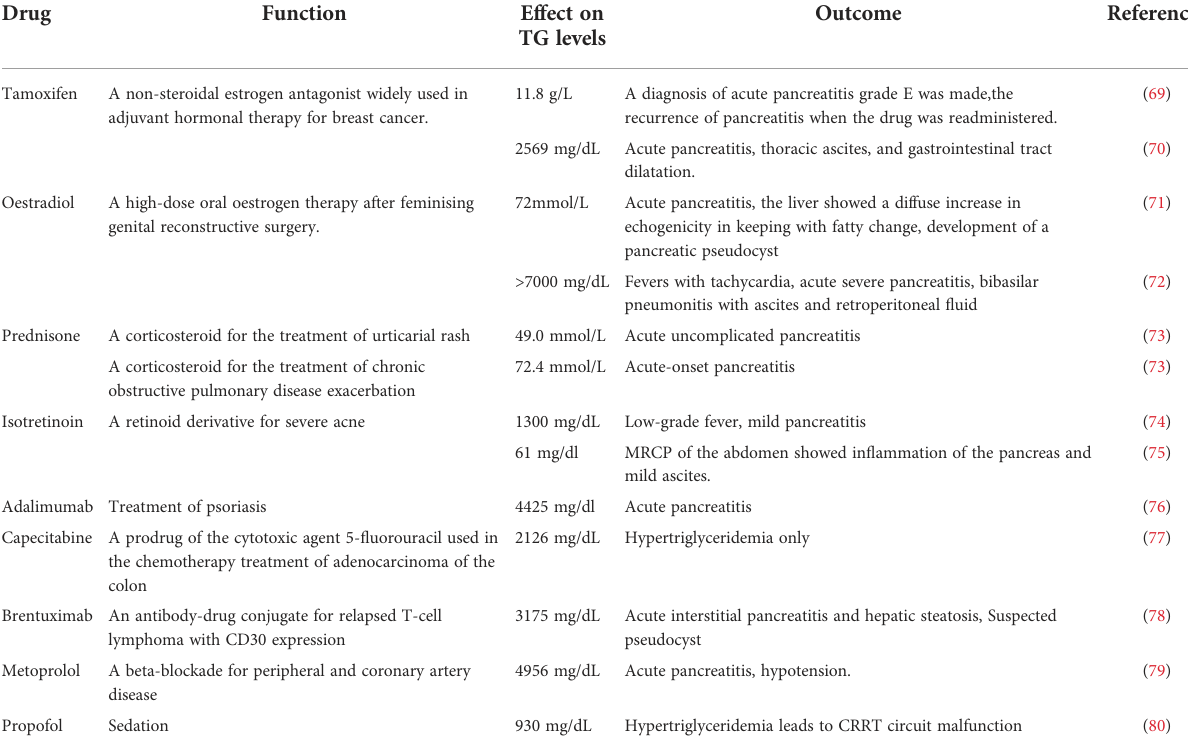
TABLE 2 Drug-induced dyslipidemia.